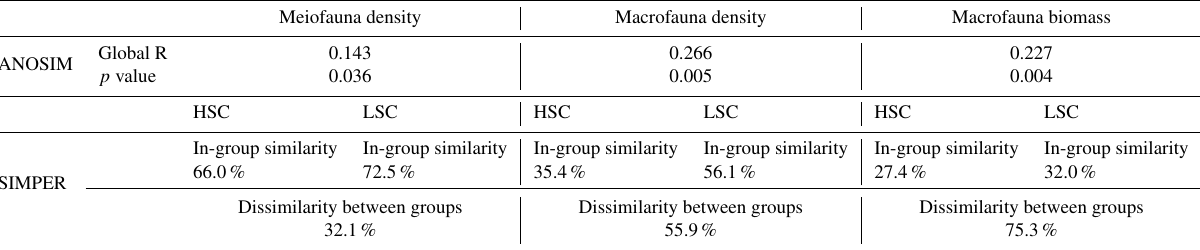
Table 4. ANOSIM and SIMPER results of the meio- and macrofauna community within sea-ice categories. The table shows that there are differences in the macrofauna community between the area of high sea-ice concentration (HSC) and low sea-ice concentration (LSC), while this is not the case for the meiofauna community. The most contributing taxa regarding the in-group similarity within the sea-ice categories and the dissimilarity between the sea-ice categories are given in Table